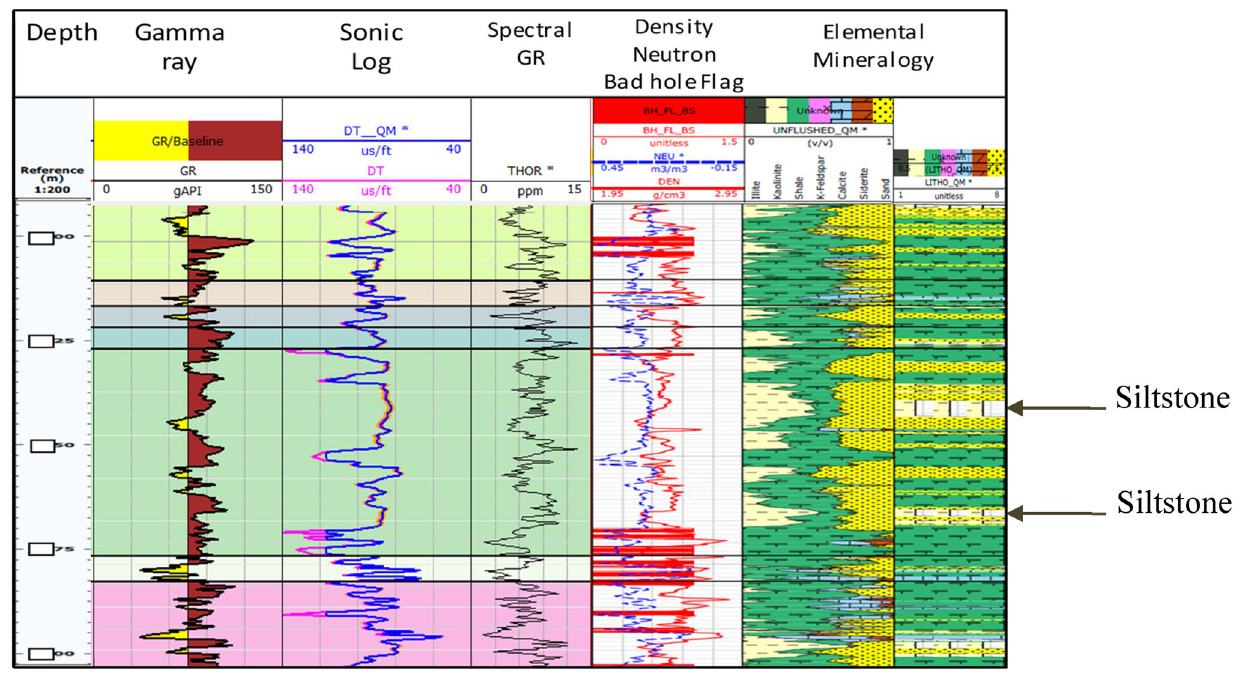
Fig. 10 Elan model input logs, output mineralogy, and interpreted lithology of pilot well Fig. 11 Bahariya histogram for types of shale